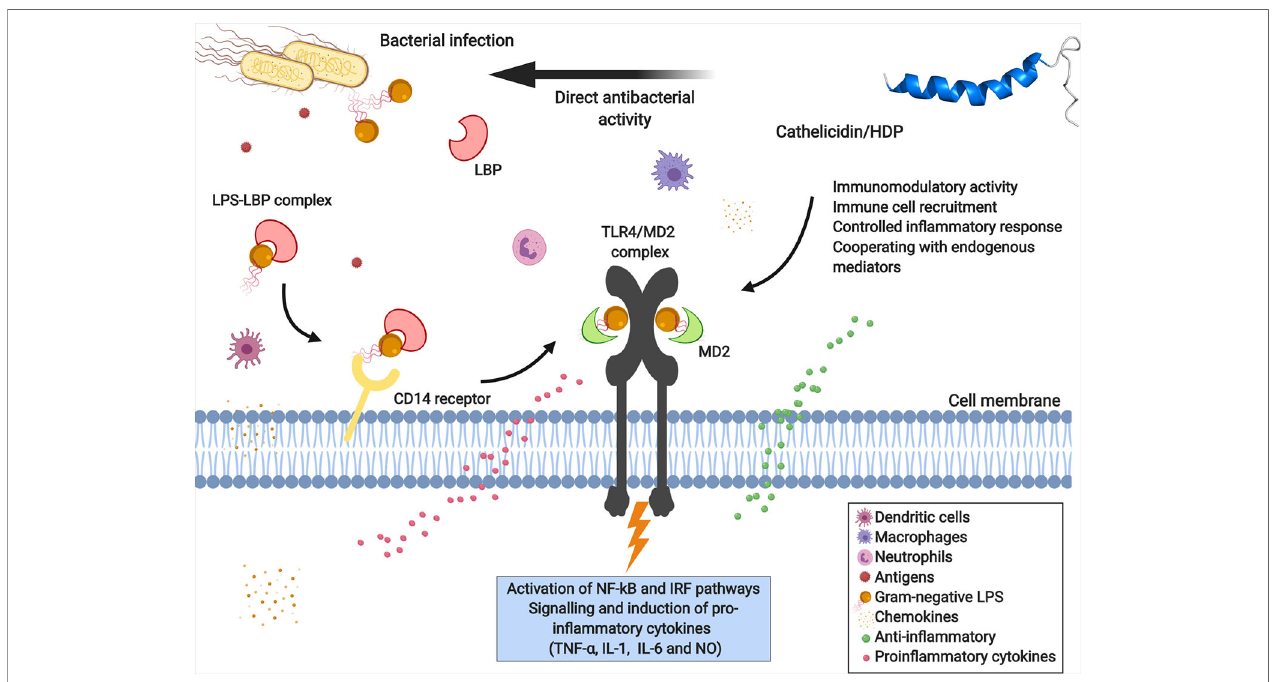
FIGURE 2 | Immunomodulatory response of cathelicidins toward bacterial LPS mediated by TLR4-MD2 complex receptor signaling. Lipopolysaccharide (LPS), the main component of the outer membrane of Gram-negative bacteria, is recognized and activated by immune defense cells, and can bind to membrane receptors of variable speci fi city and induce the synthesis of in fl ammatory mediators. LPS is recognized by LBP (LPS-binding proteins) and the LPS-LBP complex binds to the CD14 receptor, a leukocyte membrane-expressed glycoprotein. In turn, LPS is presented to the TLR4-MD2 complex (Toll-like receptor 4 and myeloid differentiation factor 2), activating the transcription factors NF- k B (nuclear factor- k B) and IRF (interferon regulatory factors), consequently inducing the production of pro- in fl ammatory cytokines, chemokines, and nitric oxide (NO). The direct interaction of cathelicidin with bacterial LPS, the CD14 co-receptor or TLR4, allows modulation of the immune response, reducing its pro-in fl ammatory effects. Created with